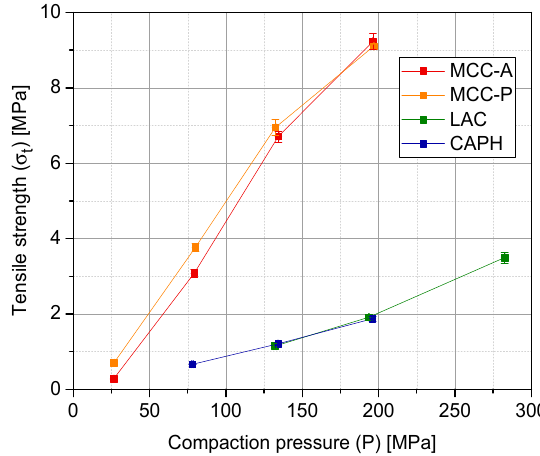
Figure 5. Tensile strength of MCC-A/P, LAC, and CAPH tablets ( n = 6).